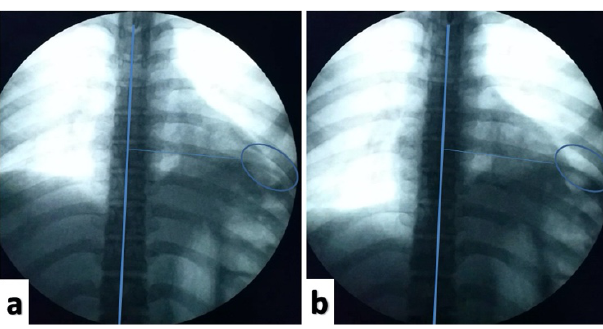
Figure 2 - Chest Fluoroscopy showing left diaphragm movement. a Exhalation. b